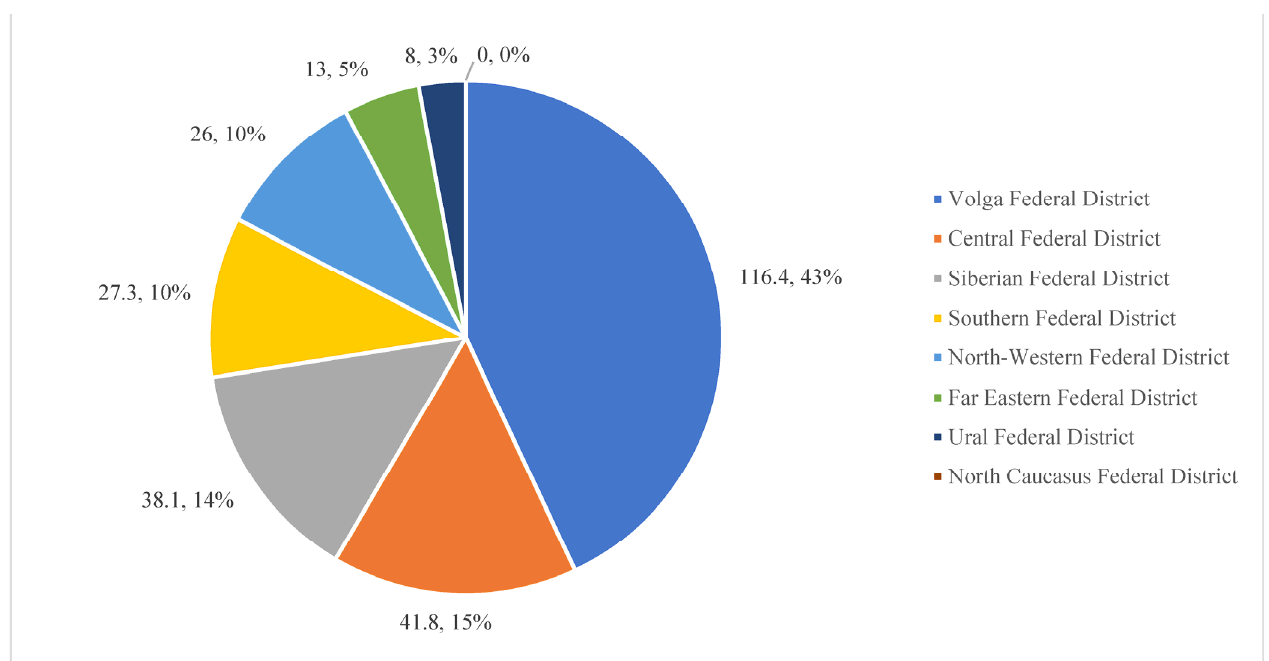
Figure 6. Grouping of the federal districts of the Russian Federation by volume of production of petroleum products, 2020.